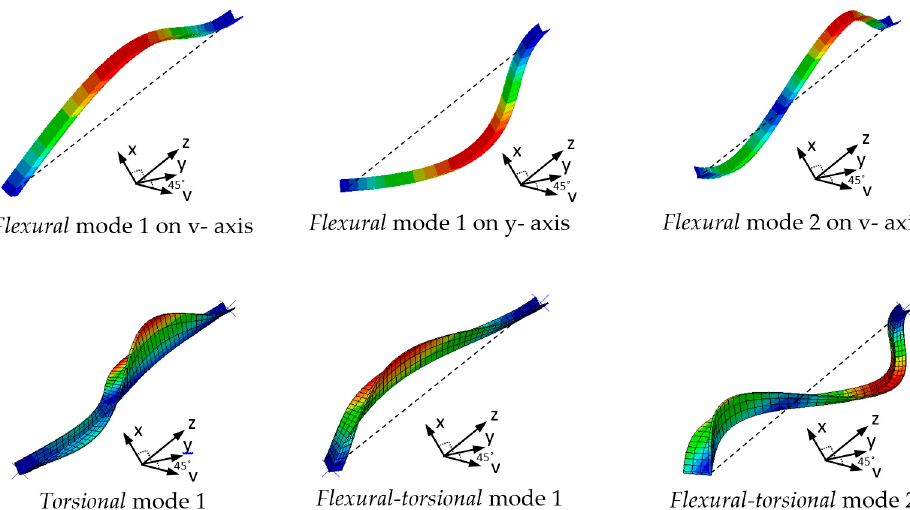
value of e quivalent stresses from low to high).